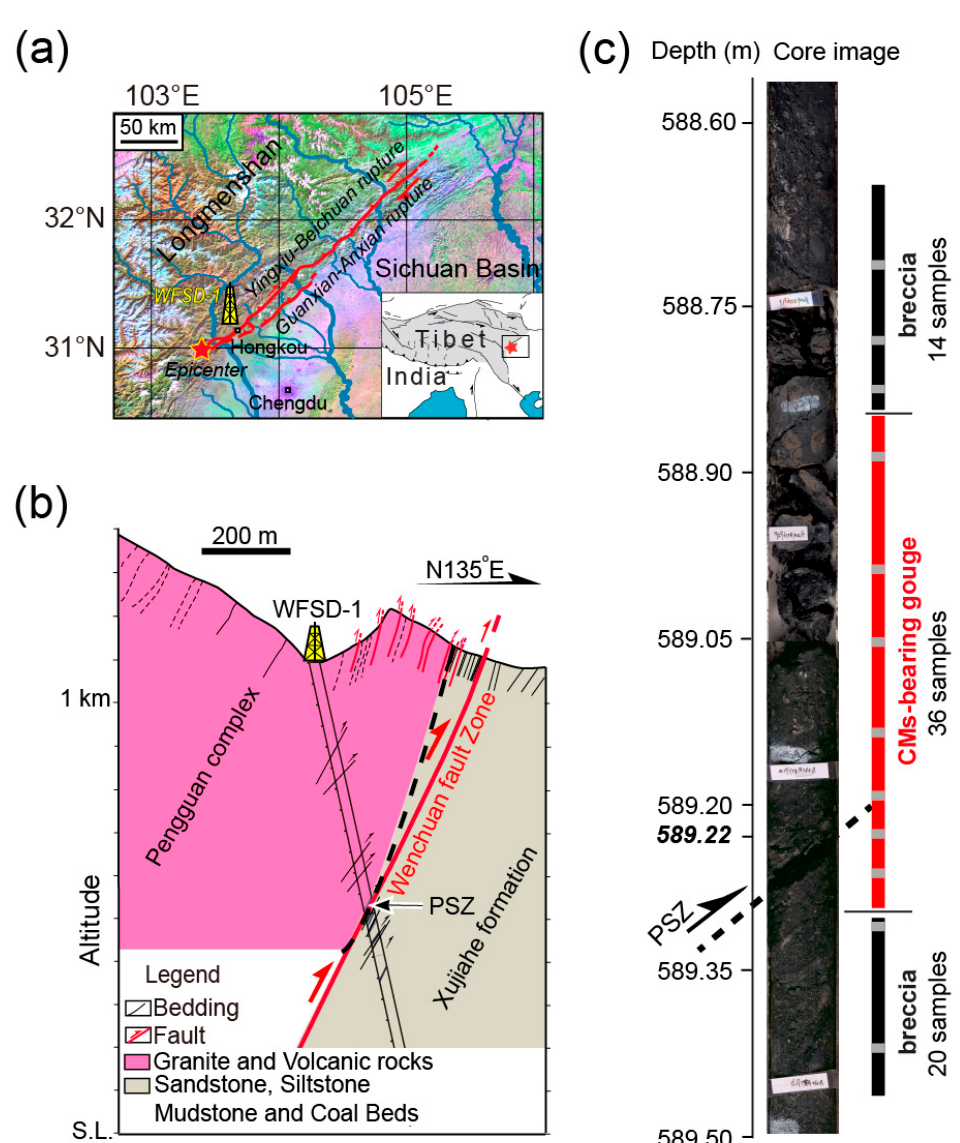
Figure 1. Geological setting of the 2008 Mw 7.9 Wenchuan earthquake, China, and location of the Wenchuan earthquake Fault Scientific Drilling project-1 (WFSD-1) drilling site, marking the major fault zone. ( a ) The 240 km-long Yingxiu–Beichuan surface rupture and the 80 km-long Guanxian–Anxian surface rupture associated with the Mw 7.9 earthquake along the margin of the Longmenshan fault belt, and the location of WFSD-1 drilling site. Red star represents epicenter of the main shock. Inset is a schematic plot of the Tibetan Plateau. ( b ) An E135 ◦ W cross section of the WFSD-1 showing the Wenchuan fault zone and surrounding formations encountered in the borehole [11]. The arrow indicating the principal slip zone active during the 2008 mainshock was identified in the borehole at 589.22 m depth and the images of fault core samples of the WFSD-1 was enlarged in the right panel as ( c ). ( c ) The core image exhibiting major portions of the Longmenshan fault along the borehole of WFSD-1 including breccia and gouge. Grey rectangles showing the location of samples analyzed by Kuo et al. [17].